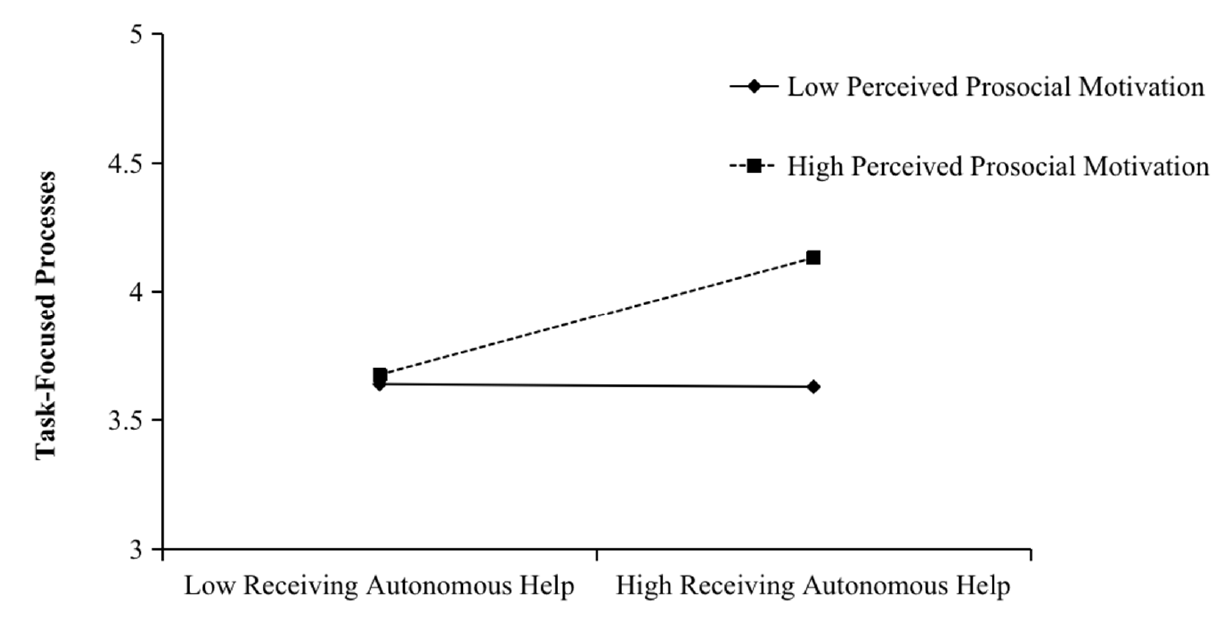
Figure 2. Moderating effect of perceived prosocial motivation on the relationship between receiving autonomous help and task-focused processes.